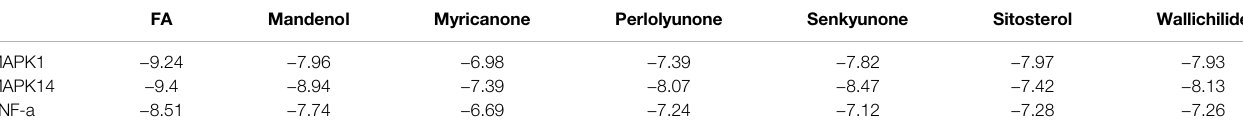
TABLE 3 | The detailed molecular docking messages of seven CX compounds with MAPK1, MAPK14, and TNF- α . FA Mandenol Myricanone Perlolyunone Senkyunone Sitosterol